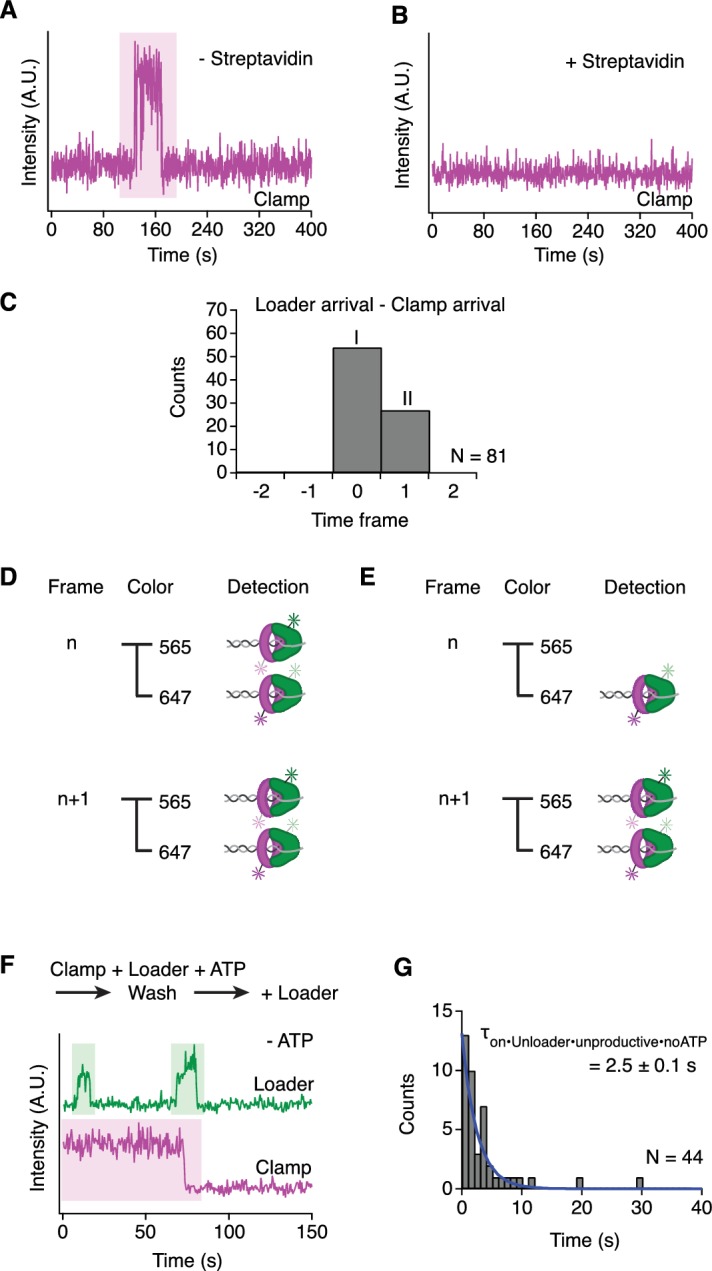
Clamp loading and clamp unloading.(A) Self-loading and unloading of clamp on open-ended DNA. (B) Lack of self-loading of clamp on end-blocked DNA. (C) Histogram showing the simultaneous arrival of loader and clamp on DNA (same as main Figure 2B) (D) Schematic representation of how the simultaneous arrival of two proteins can be recorded in a single image or (E) on two sequential images. (F) Representative trace showing sequentially an unsuccessful and a successful clamp unloading event. (G) The distribution of lifetimes for the unsuccessful unloading attempts by the clamp loader. All values represent mean lifetime ±s.e.m.